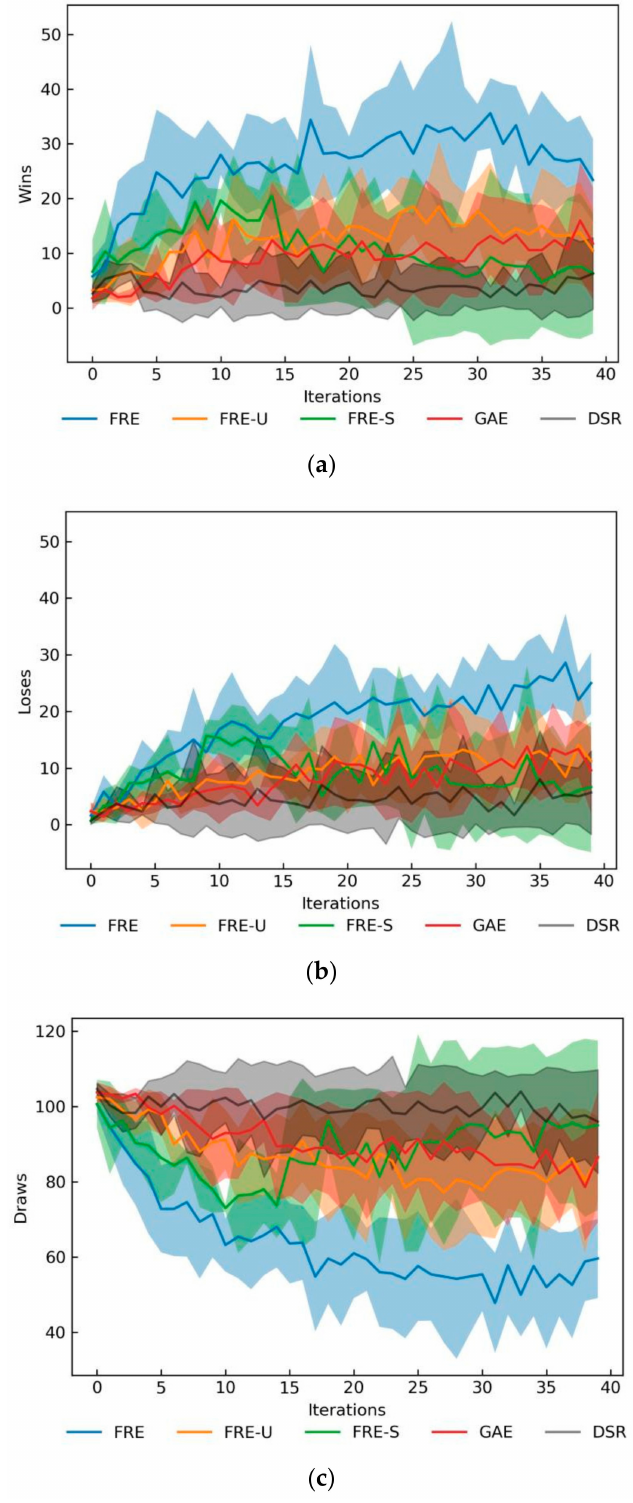
Figure 4. ( a ) Wins, ( b ) Losses, and ( c )